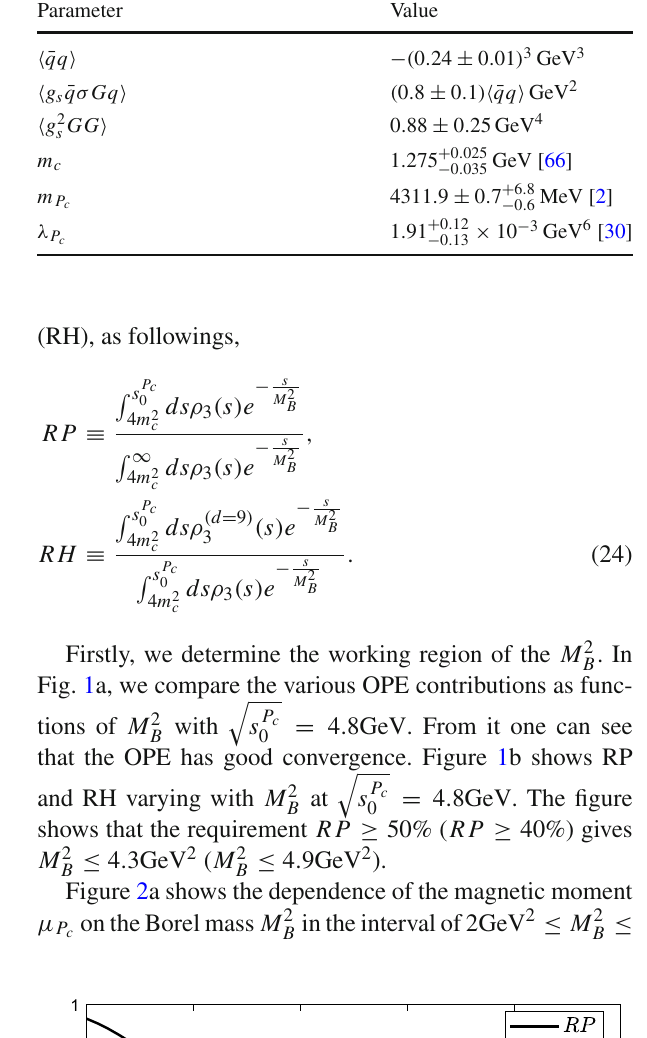
(cid:16) = 4 . 8GeV; b represents RP and RH varying with M 2 s P c with B 0